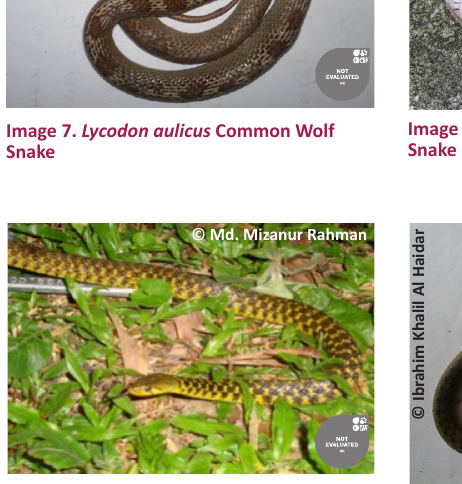
Image 10. Xenochrophis piscator Checkered Keelback